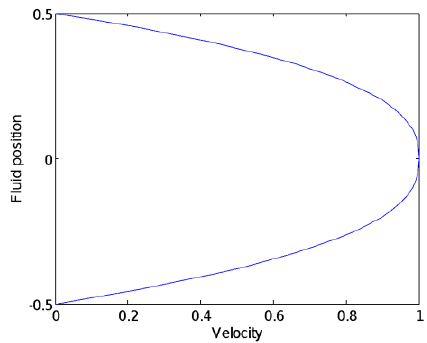
Figure 10. A diagram of the one-dimensional flow velocity distribution.